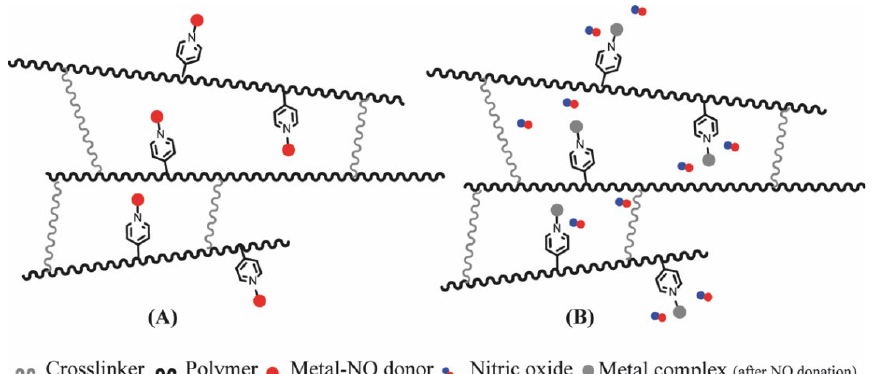
Figure 5. NO-releasing hydrogel with NO donor covalently linked to a pyridine derivate inserted in the polymeric chain. Before ( A ) and after ( B ) irradiation. Adapted from [122].